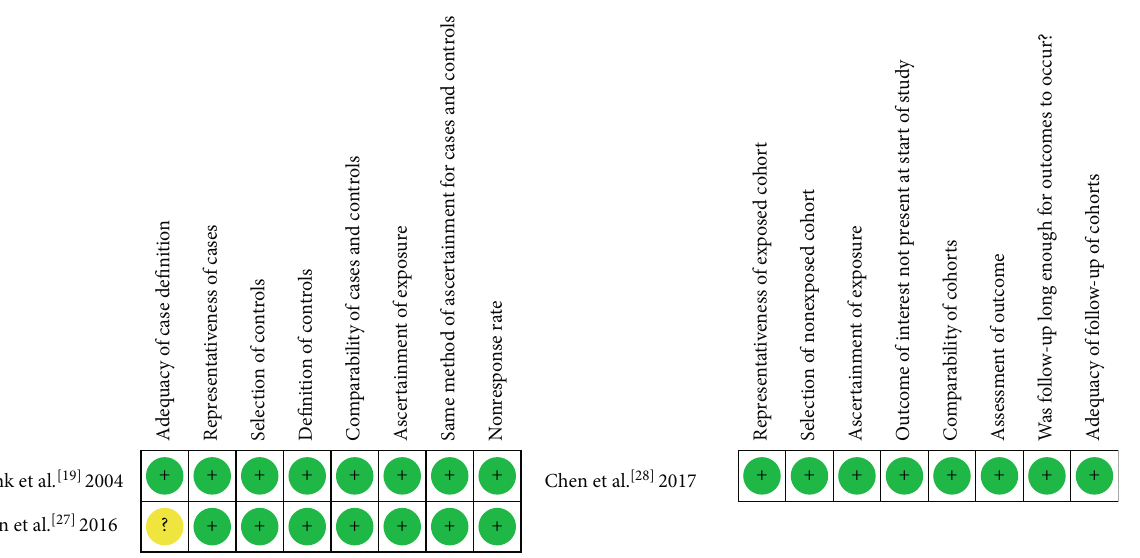
Figure 2: Risk of bias of included studies. High risk of bias (+); unclear risk of bias (?); low risk of bias Table 2: Association between pancreatitis and in fl ammatory bowel disease. Trails Study design 1. The risk of Crohn disease in the patients with chronic pancreatitis Chen 2017 Cohort study OR 2. The risk of ulcerative colitis in the patients with chronic pancreatitis. Chen 2017 Cohort study OR Munk 2004 Case-control study OR Munk 2004 Case-control study OR Chen 2016 Chen 2016 Case-control study OR < 0.00001